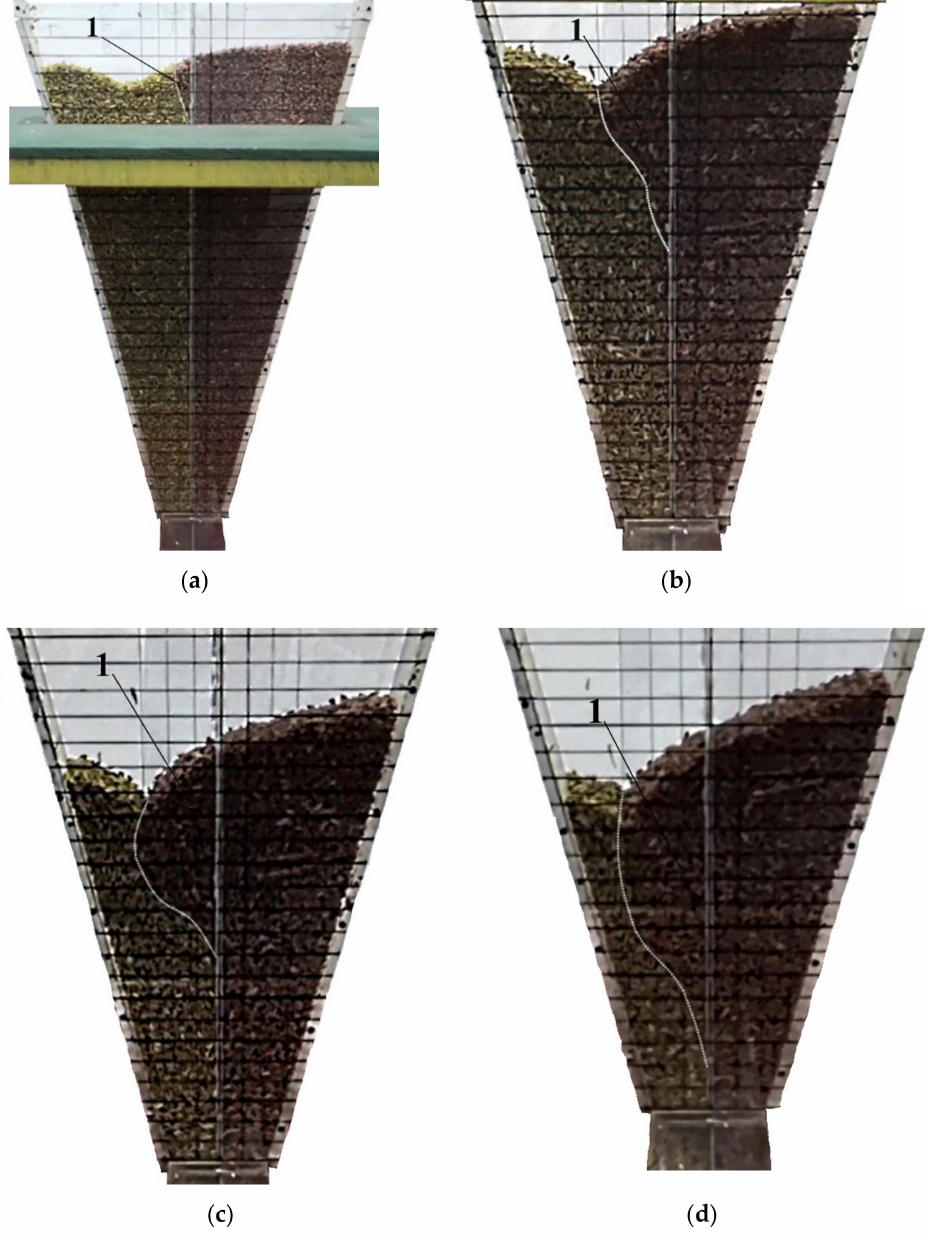
Figure 9. Distribution of seeds between the two sections of the unloading hopper while moving from the convective-microwave zone towards the hopper outlet hole: ( a ) 4 cm from grain layer surface; ( b ) 22 cm from grain layer surface; ( c ) 28 cm from grain layer surface; ( d ) 32 cm from grain layer